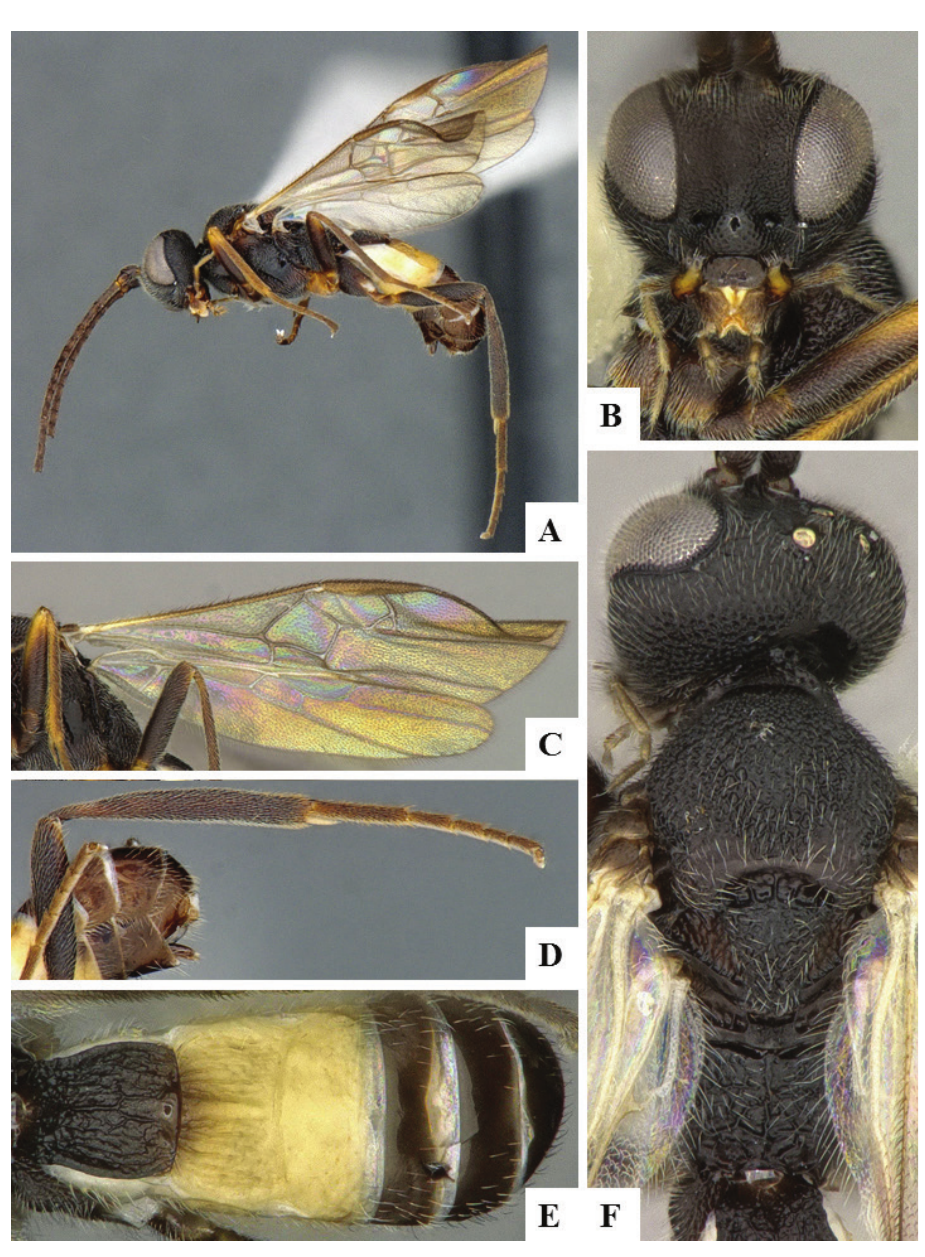
Figure 20. Jenopappius magyarmuzeum female holotype. A Habitus B Head frontal C Fore wing and hind wing D Ovipositor and hind leg E Metasoma dorsal F Mesosoma dorsal. (0.12); Outer spur L: 0.13 (0.13); First segment of Metatarsus L: 0.40 (0.39); Oviposi- tor sheaths L: 0.13 (0.13); Body L: 2.73 (2.93); Fore wing L: 2.55 (2.53). Maximum W of T1 and T1 W at anterior margin are approximate for one